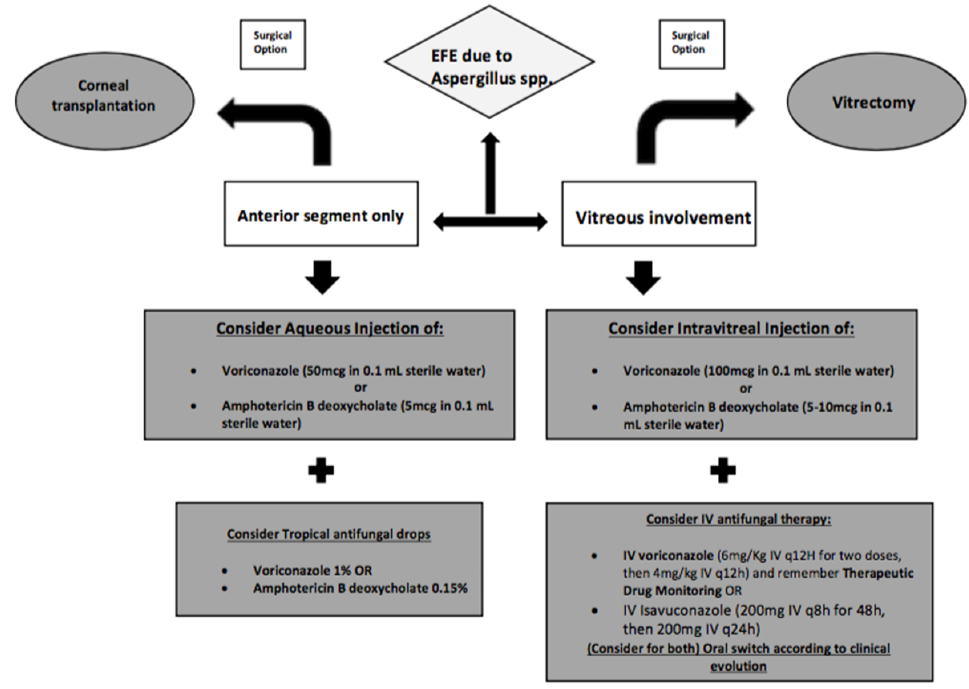
Figure 2. Practical guidelines for clinical management of exogenous fungal endophthalmitis .